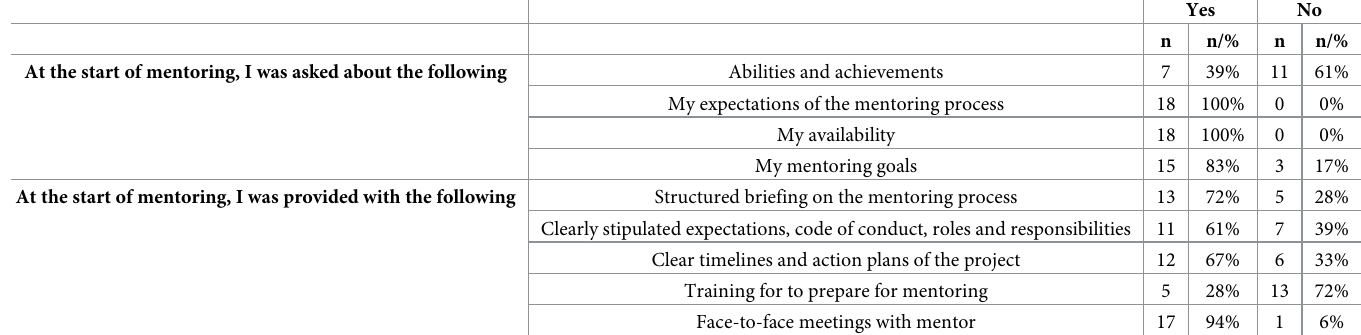
Table 6. Recruitment and matching process.